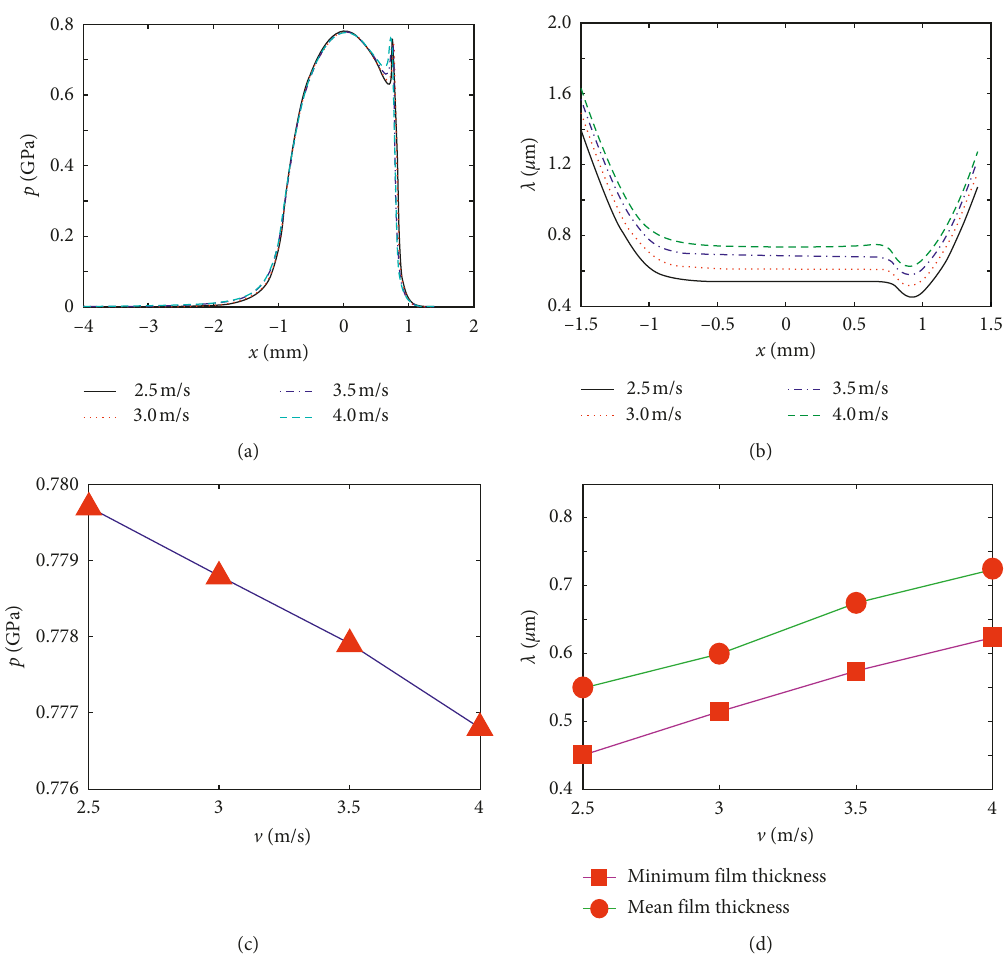
Figure 13: Comparison of lubrication characteristics under different contact-pair speeds: (a) film pressure distribution; (b) film thickness distribution; (c) maximum film pressure; (d) minimum and mean film